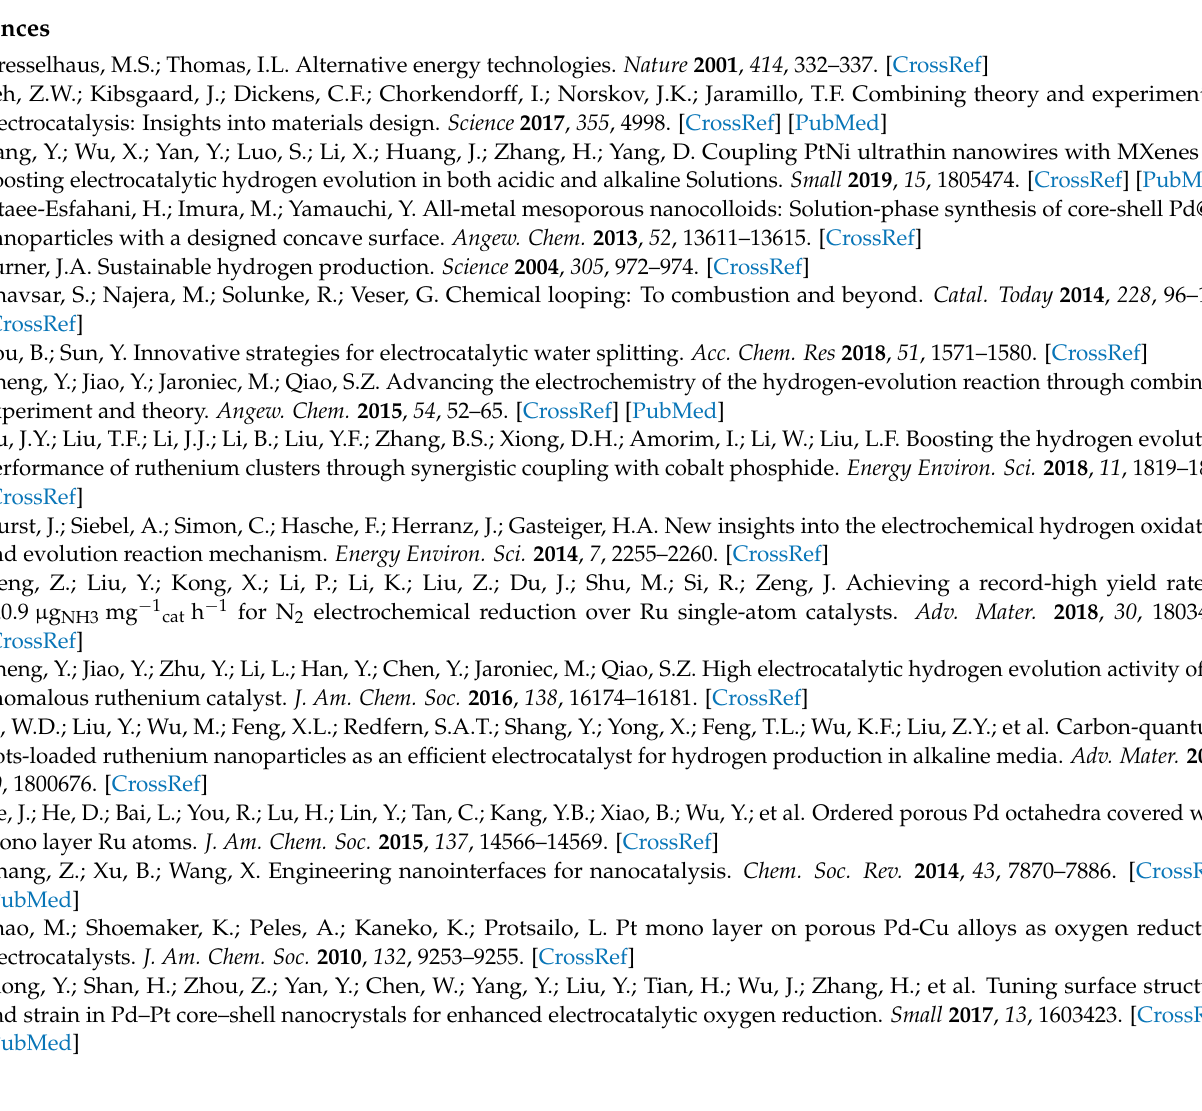
Table S1. ICP-AES data of the PdCuRu multimetallic nanoplates with different atomic ratios and the molar ratio of the Pd, Cu and Ru precursors fed in the synthesis. Table S2. The variation in the atomic percentage of Pd, Cu, and Ru for the Pd 24 Cu 29 Ru 47 nanoplates with the reaction time measured by ICP-AES